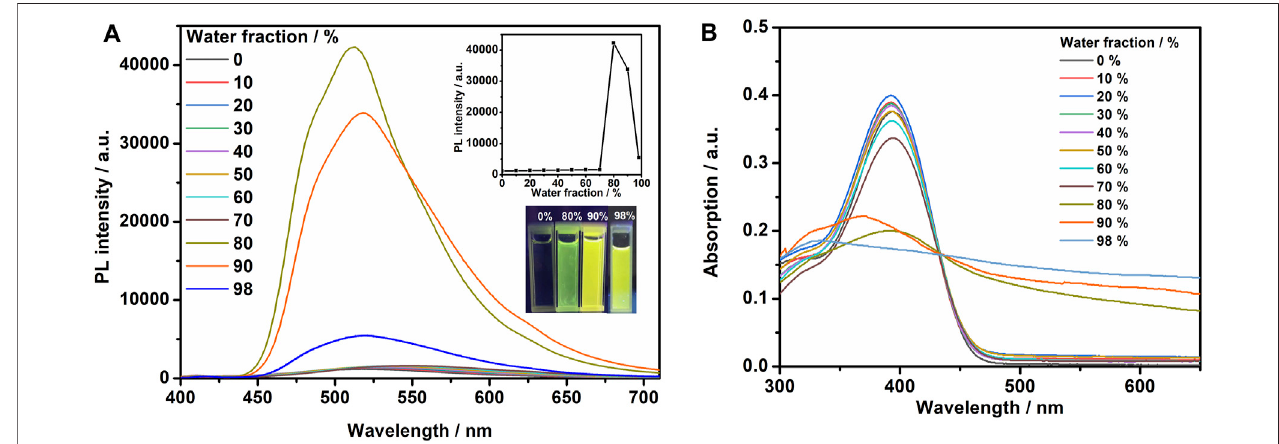
FIGURE1|(A) FluorescencespectraofTPEBZMZinTHF/watermixedsolvents(10 mM)withdifferentwaterfractions.Theinsetsshowchangesinpeakintensityof the fl uorescence spectra and emission images of the compounds in different water fraction mixtures under 365 nm UV illumination. (B) UV – vis absorption spectra of TPEBZMZ in THF/water mixed solvents (10 mM) with different water fractions.